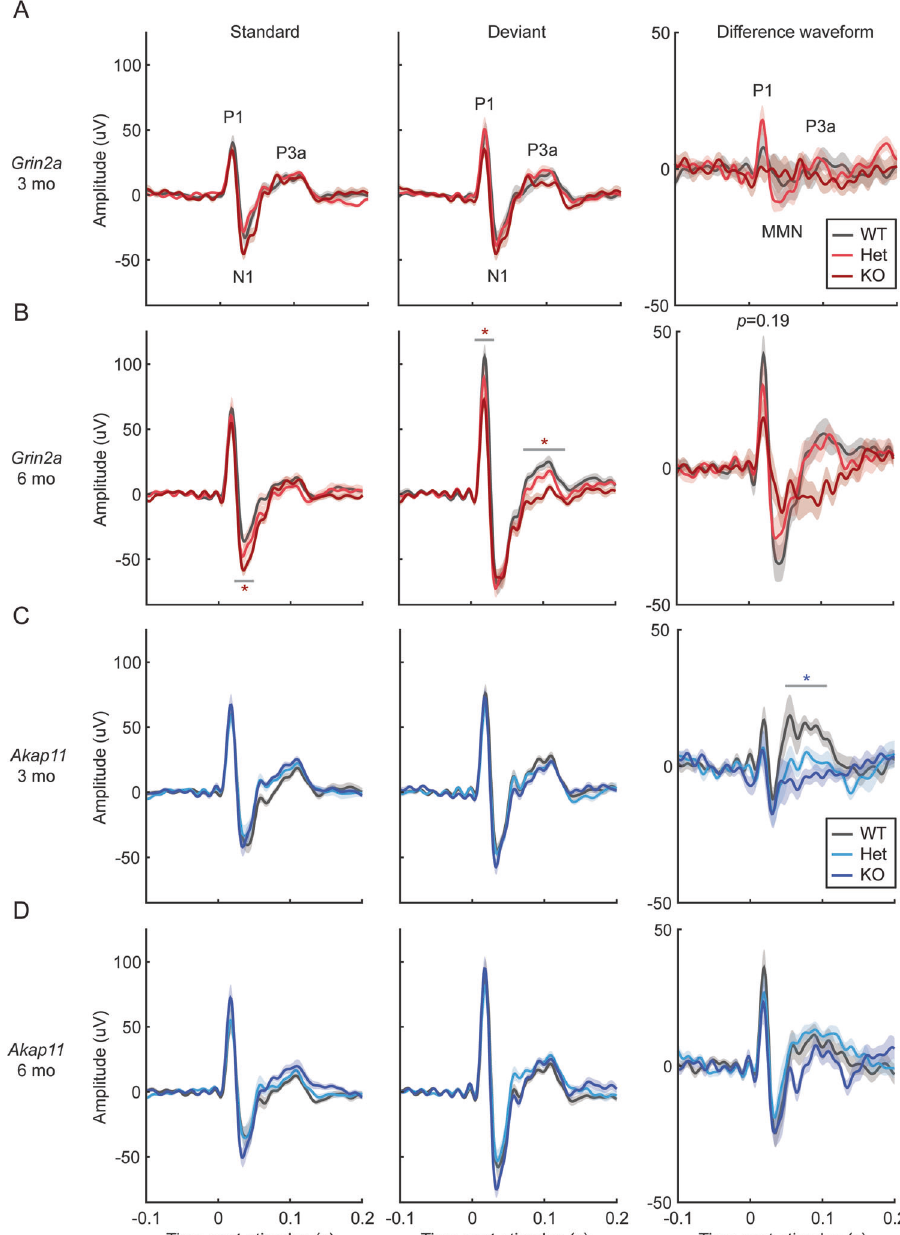
Fig. 6 Mismatch negativity (MMN) responses in Grin2a and Akap11 mutants. A – D Mean response to standard ( n = 900 trials), deviant ( n = 100 trials) and difference waveforms [response to deviant tones minus the response to standard tones], averaged across each genotype. Shading indicates mean ± standard error. Red or blue asterisks indicate statistical differences in peak amplitude between WT and KO animals, which was assessed for the P1, N1/MMN, and P3a peaks (as indicated on the fi rst graphs). p < 0.05, ** p < 0.01, *** p < 0.001; n = 11 – 12 mice/